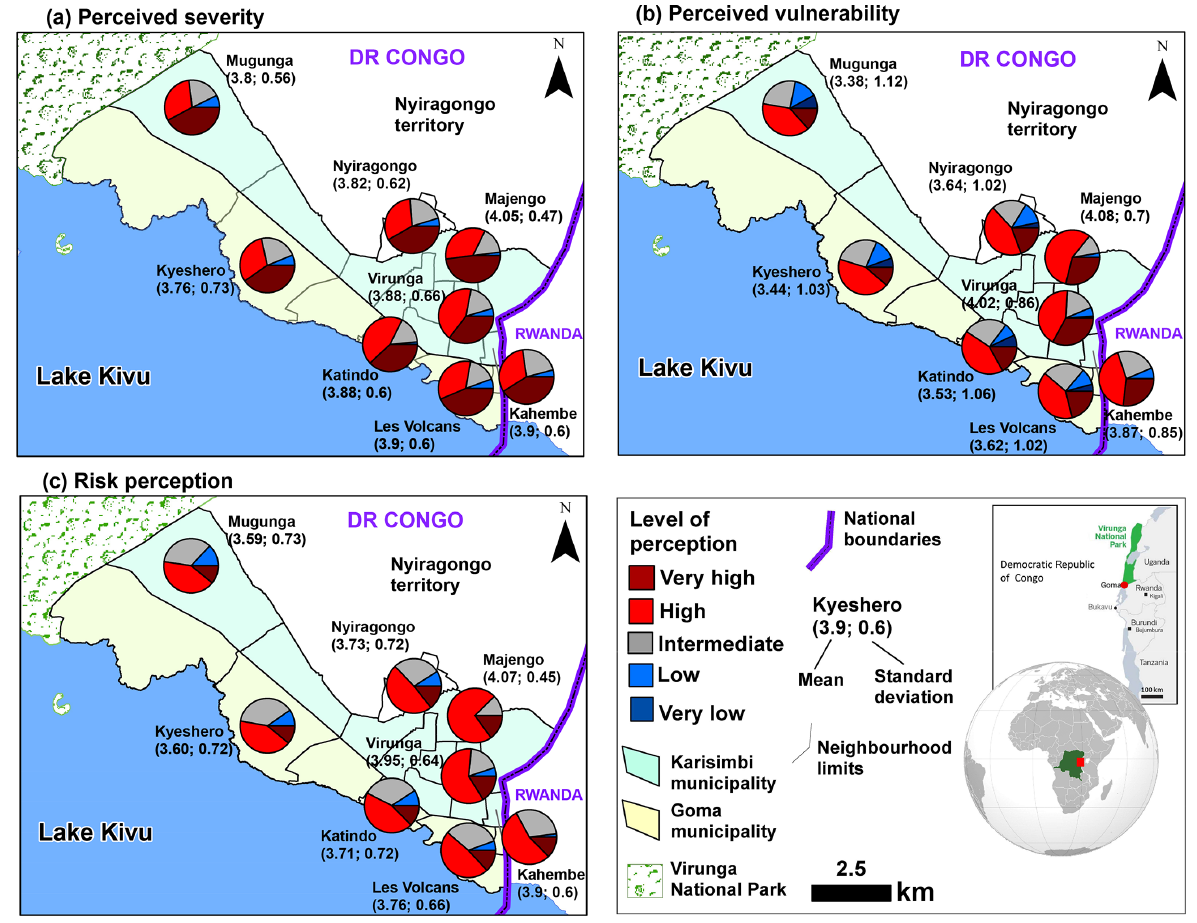
Figure 6. Spatial variation of (a) perceived severity, (b) perceived vulnerability and (c) risk perception. The perception levels were converted into a numerical scale (very low = 1 to very high = 5). The mean indicates the average level of perception by neighbourhoods with a range of variation within the neighbourhood (standard deviation). The spatial variation across all neighbourhoods was determined by the coefficient of variation of the perception indicator within all the neighbourhoods. It is 36.8% for the perceived severity, 27.0% for the perceived vulnerability and 18.0% for the perception of